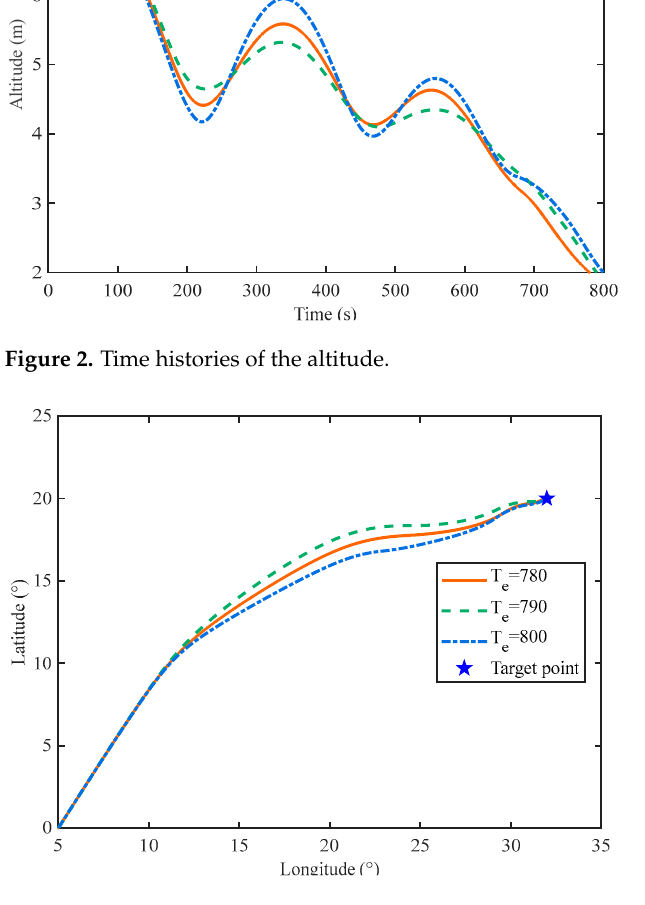
Figure 3. Latitude and longitude changes.